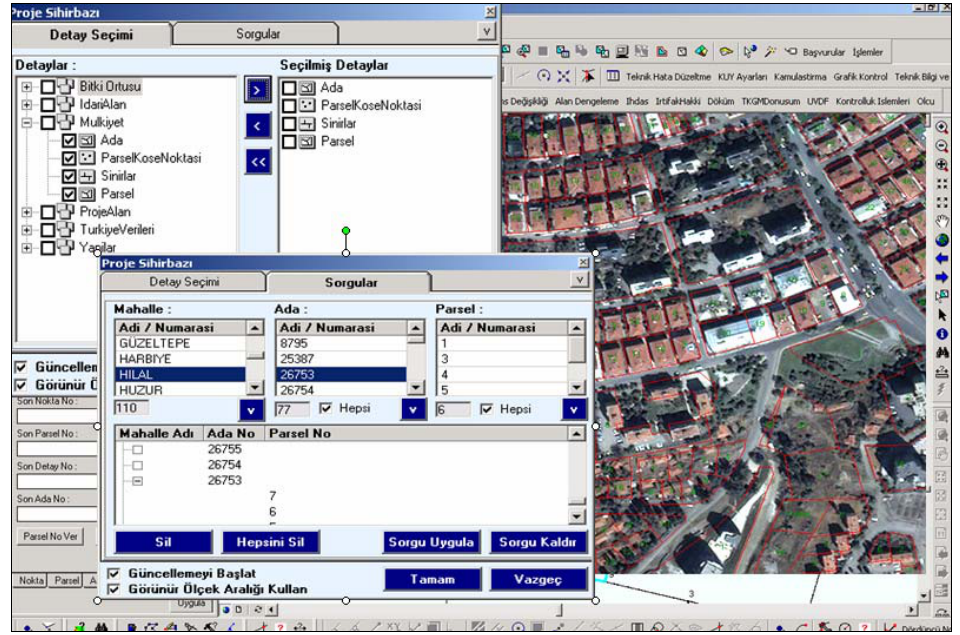
Figure 2. Land parcels, data base integration and related information (geometric and attribute) with the combination of aerial photograph and cadastral